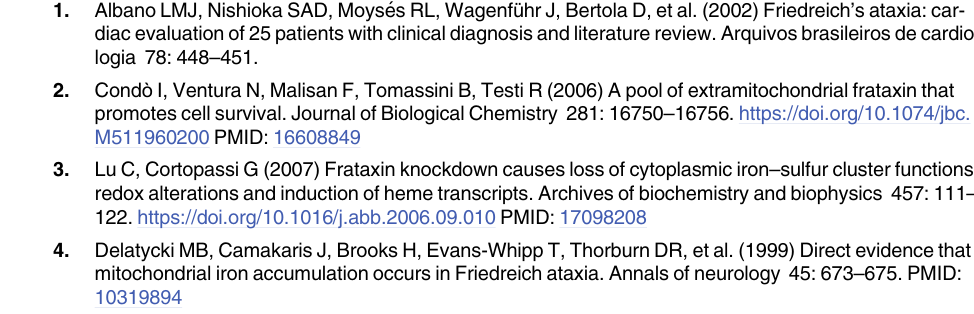
S3 Fig. RNAse-H treatment of patient cells eliminated R-loop